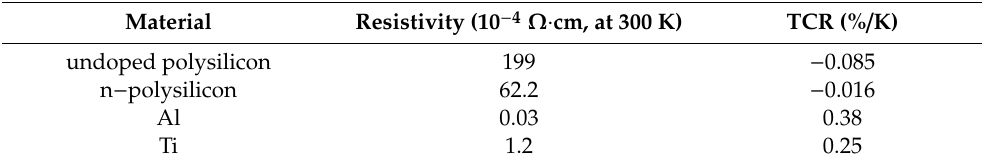
Table 1. Resistivity and temperature coe ffi cient of resistance (TCR) of several complementary metal oxide semiconductor (CMOS)-compatible materials